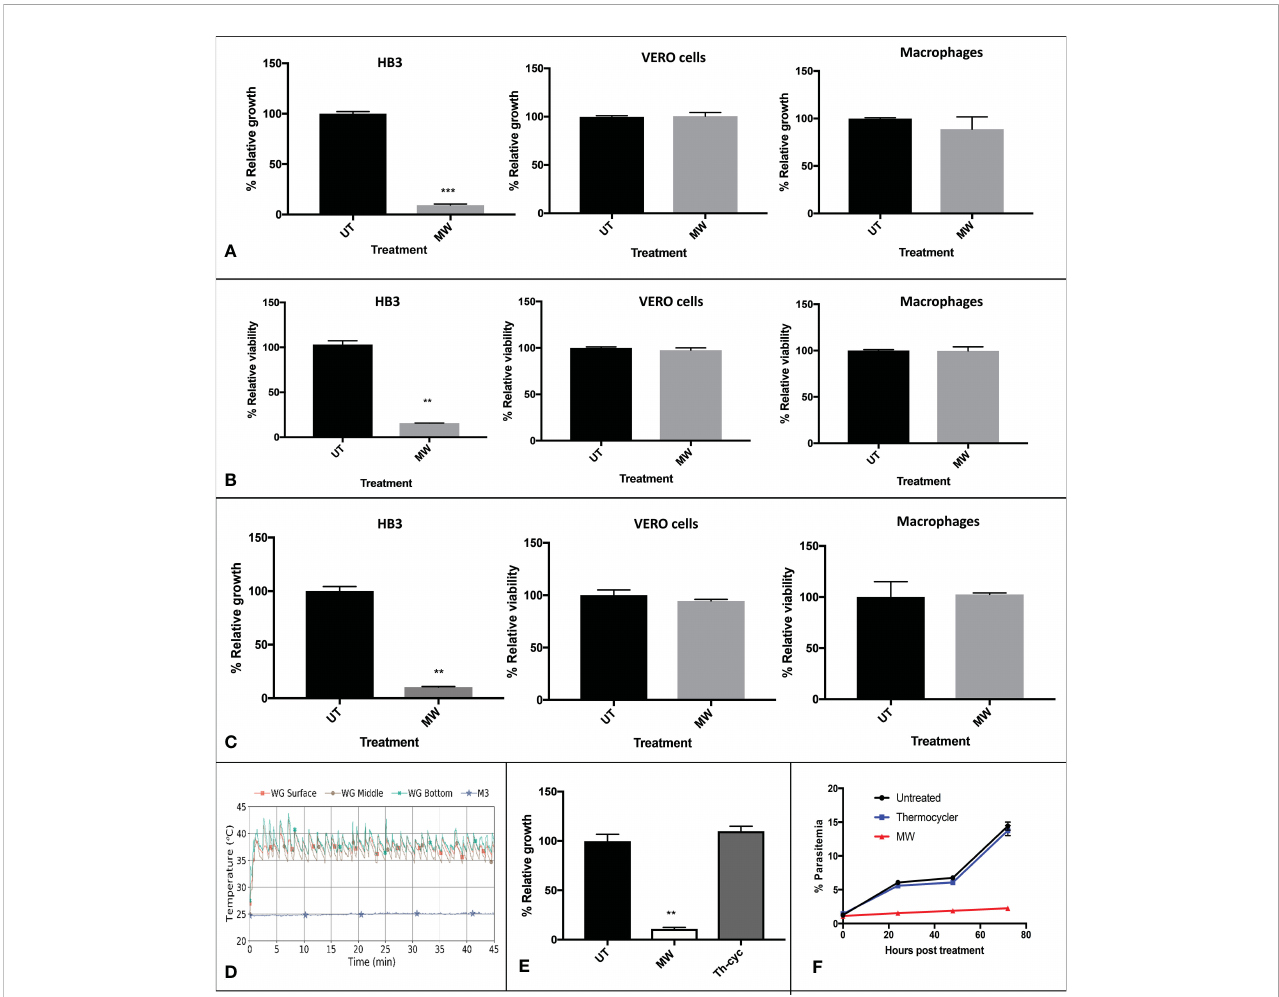
FIGURE 3 Non thermal effects of MW on P. falciparum parasites or mammalian cells. (A) Representative pattern of temperature changes caused by exposure of P. falciparum -infected cultures to MW. Infected cultures, epithelial (Vero) cells or J-774 macrophages were untreated or exposed to MW in the (A, B) WG or (C) M3 and the growth or viability of duplicates was assessed 24 h after treatment. Data was acquired through: A, fl ow cytometry for HB3 (n=3), and fl uorometry with sulforhodamine for cells (n=2); B, MTT assays for all; (HB3, n=1; Vero cells and macrophages, n=3); C, fl ow cytometry for HB3 (n=3) and MTT assays for cells treated with M3 (n=3). (D) Fluctuations of temperature of the infected, exposed culture with both MW applicators. (E) Using a representative temperature pro fi le generated in the WG, samples were either submitted to the same temperature fl uctuations by using a thermocycler, or exposed to the MW treatment in the WG, and their growth was monitored 24 h later by fl ow cytometry. A representative experiment is shown. n=3. One-way ANOVA was used throughout. (F) Growth of thermo- or MW- treated parasites was monitored for 72 hours by fl ow cytometry. One representative experiment is shown. n=2. **p<0.01, ***p<0.005.